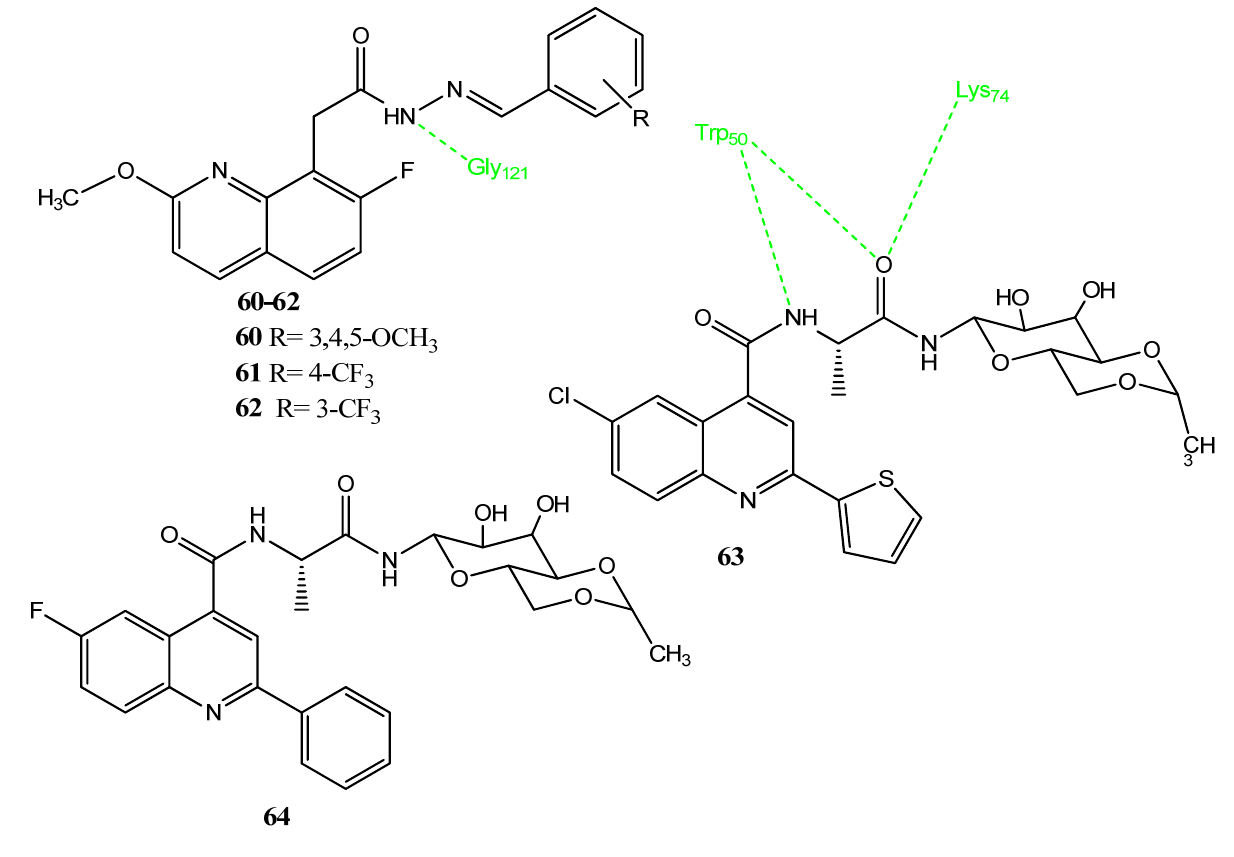
Figure 13. Quinoline–based molecules.